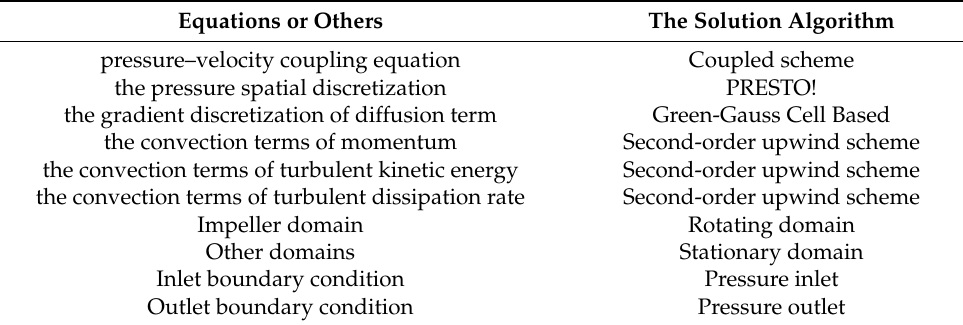
Table 1. The Initial and Boundary Conditions.